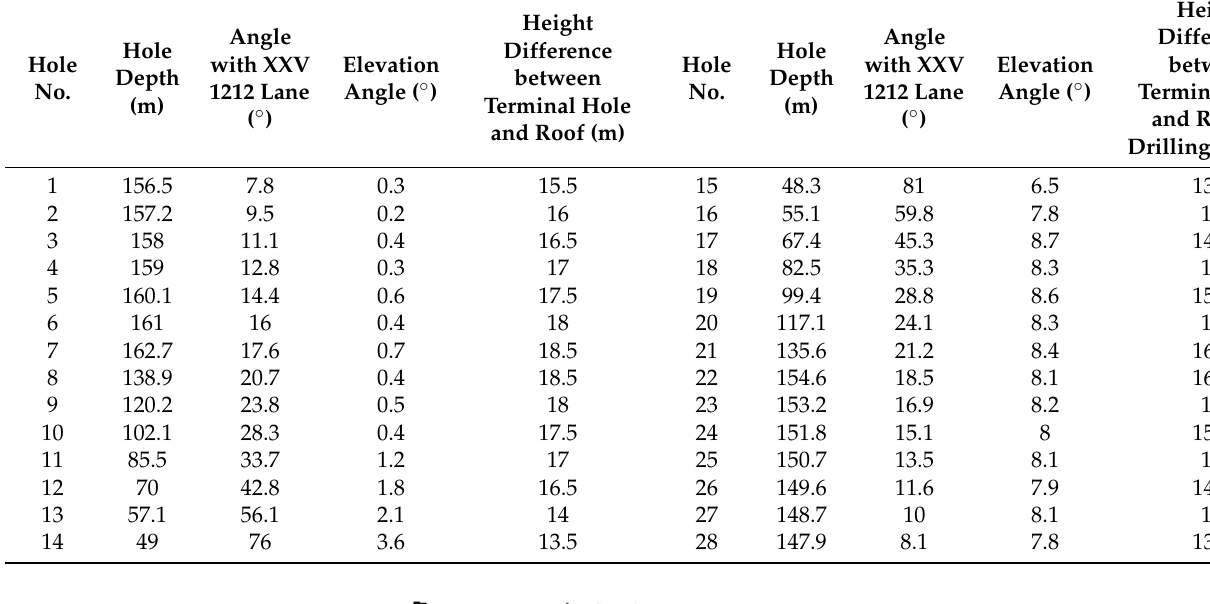
Table 4. XV1306 working face high-level drilling field drainage borehole layout parameters.